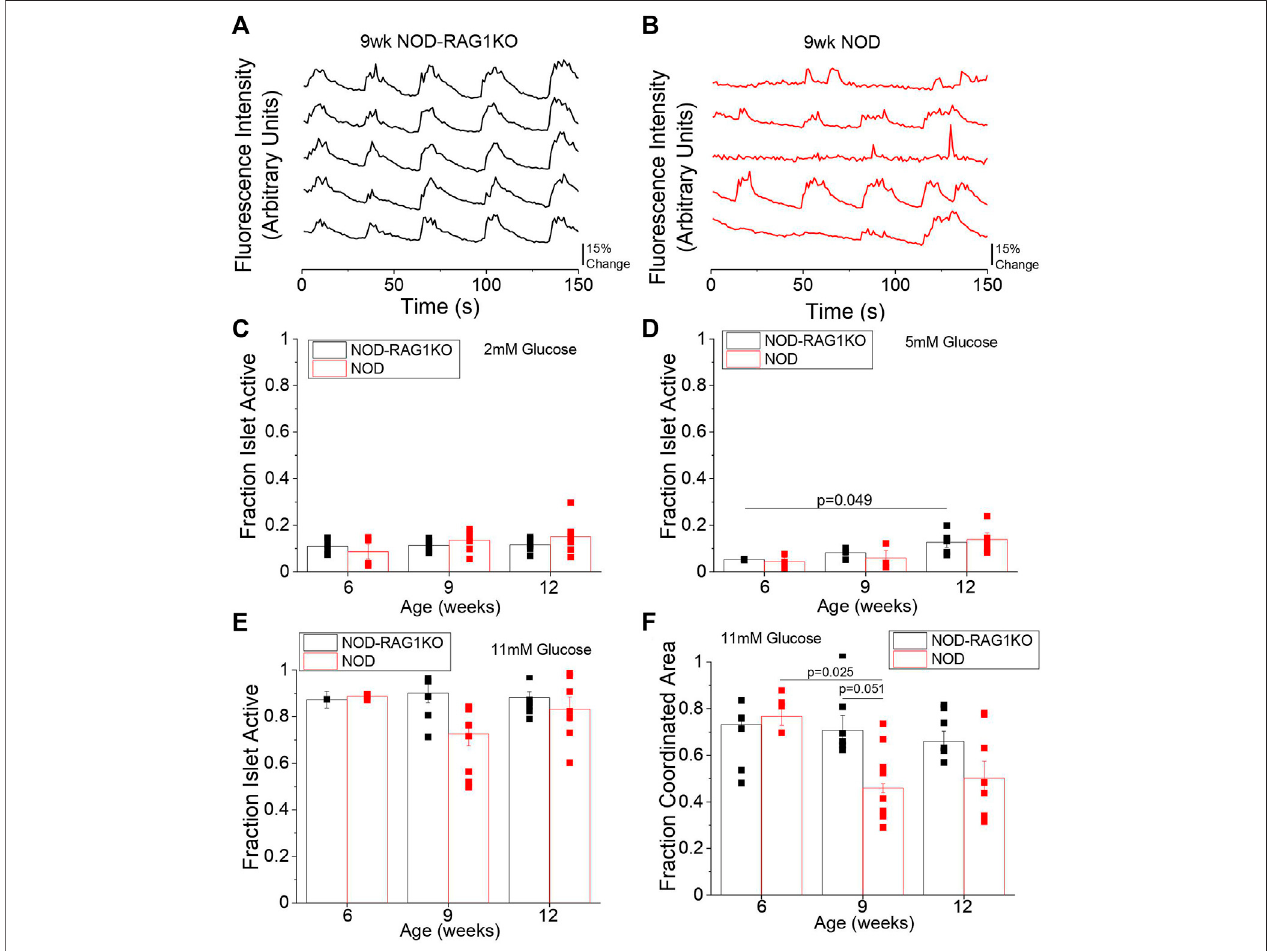
FIGURE 2 | NOD mice have altered Ca 2+ signaling as early as 9 weeks of age. Representative plots of intracellular Ca 2+ as measured by fl uorescence intensity at 11 mM glucose in 5 individual cells in the same islet over time in 9-week old (A) NOD-RAG1KO (black, n = 3 – 4) and (B) NOD (red, n = 3 – 5) mice. Quanti fi cation of the fraction of the islet area showing intracellular Ca 2+ activity at (C) 2 mM glucose, (D) 5 mM glucose, and (E) 11 mM glucose in isolated islets from 6, 9, and 12-week old NODandNOD-RAG1KOmice. (F) Quanti fi cationofthefractionoftheisletareawithcoordinatedCa 2+ oscillationsat11 mMglucoseinisolatedisletsfrom6,9,and 12-week old NOD and NOD-RAG1KO mice. Data in C-F represents the mean ± SEM. Data from individual mice are represented by black and red squares for NOD- RAG1KO and NOD mice respectively ( n = 3 – 6). p < 0.05 is signi fi cant as determined by ANOVA. All animals are female unless otherwise noted.